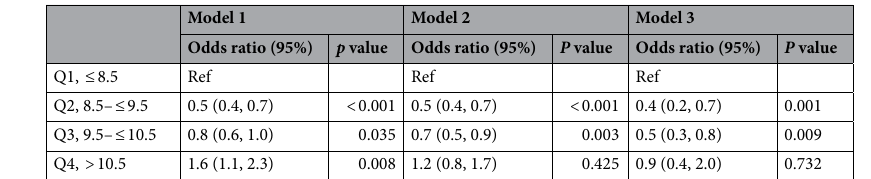
Table 3. Association of corrected serum calcium and the incidence of in-hospital mortality. Model 1 adjust for: none. Model 2 adjust for: age; sex; BMI; chronic renal insufficiency. Model 3 adjust for: age; sex; BMI; chronic renal insufficiency; COPD; diabetes mellitus; stroke; history of malignancy; hemoglobin; TC; LDL-C; HDL-C; lipid-lowering drugs; antiplatelet; anticoagulants;